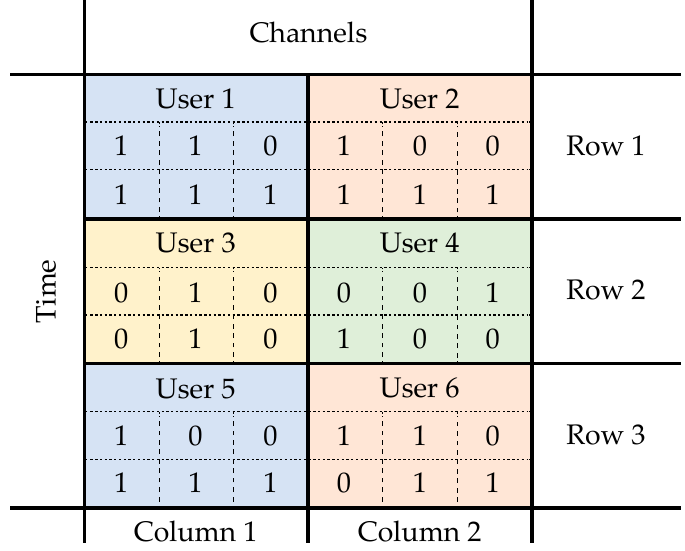
Figure 7. Availability matrix sectioned for six users with row division.